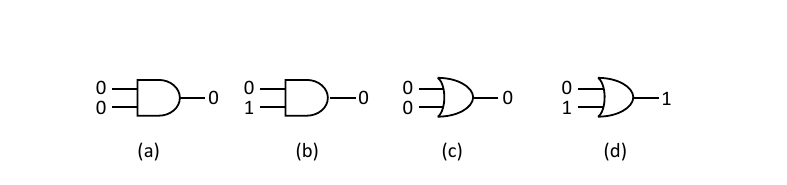
and the bottom bit is l 1 min